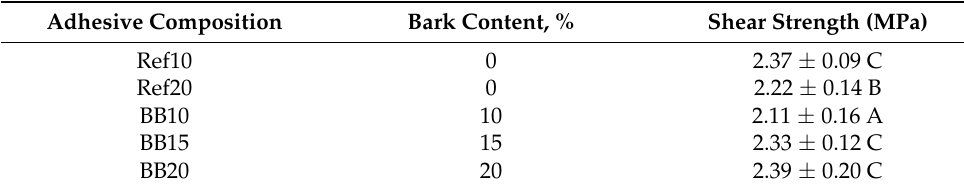
Table 6. Shear strength of laboratory-produced plywood panels. Adhesive